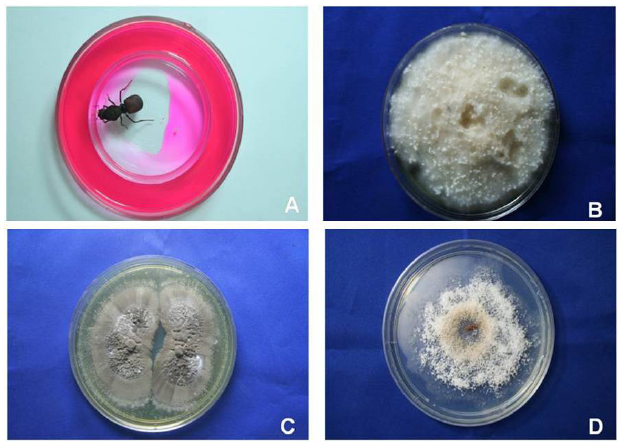
Fig 1 . General aspect of the wet chamber used in the study. Moist chambers were made from Petri dish of 60 x 12 submerged in an another dish of 100 x 16 mm containing water-agar (medium dyed red for contrast for picture) to promote regurgitation of pellets of the mutualistic fungus (A); the mutualistic fungus (B); filamentous fungi isolated from the pellet (C); parasitic fungus Escovopsis , isolated from a colony of Atta sexdens (D). For B, C and D, the culture medium is PDA (Potato Dextrose Agar).